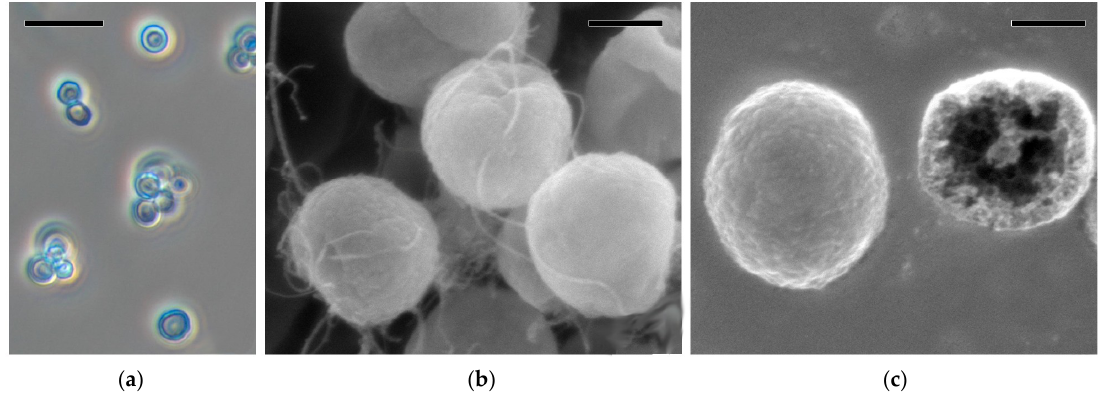
Figure 3. PMC micrographs obtained by phase-contrast microscopy ( a ) and scanning electron microscopy (( b ) intact capsules and ( c ) open capsules). Scale bars are 10 µm (a) or 1 µm ( b , c ).